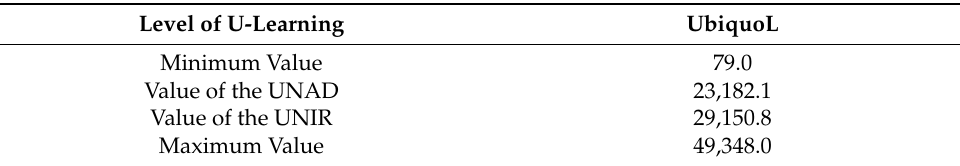
Table 4. Level of Ubiquity of Institutions according to the U-CLX